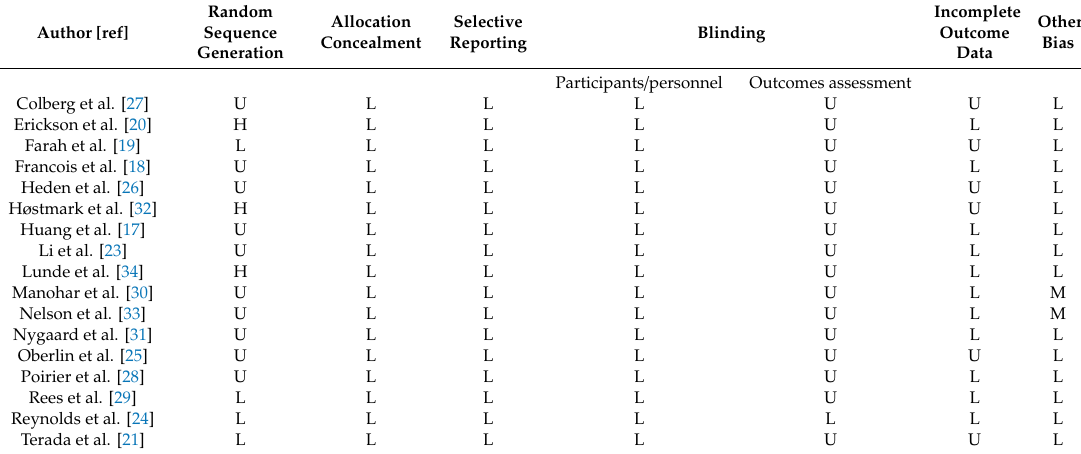
Table 2. Risk of bias assessment of included